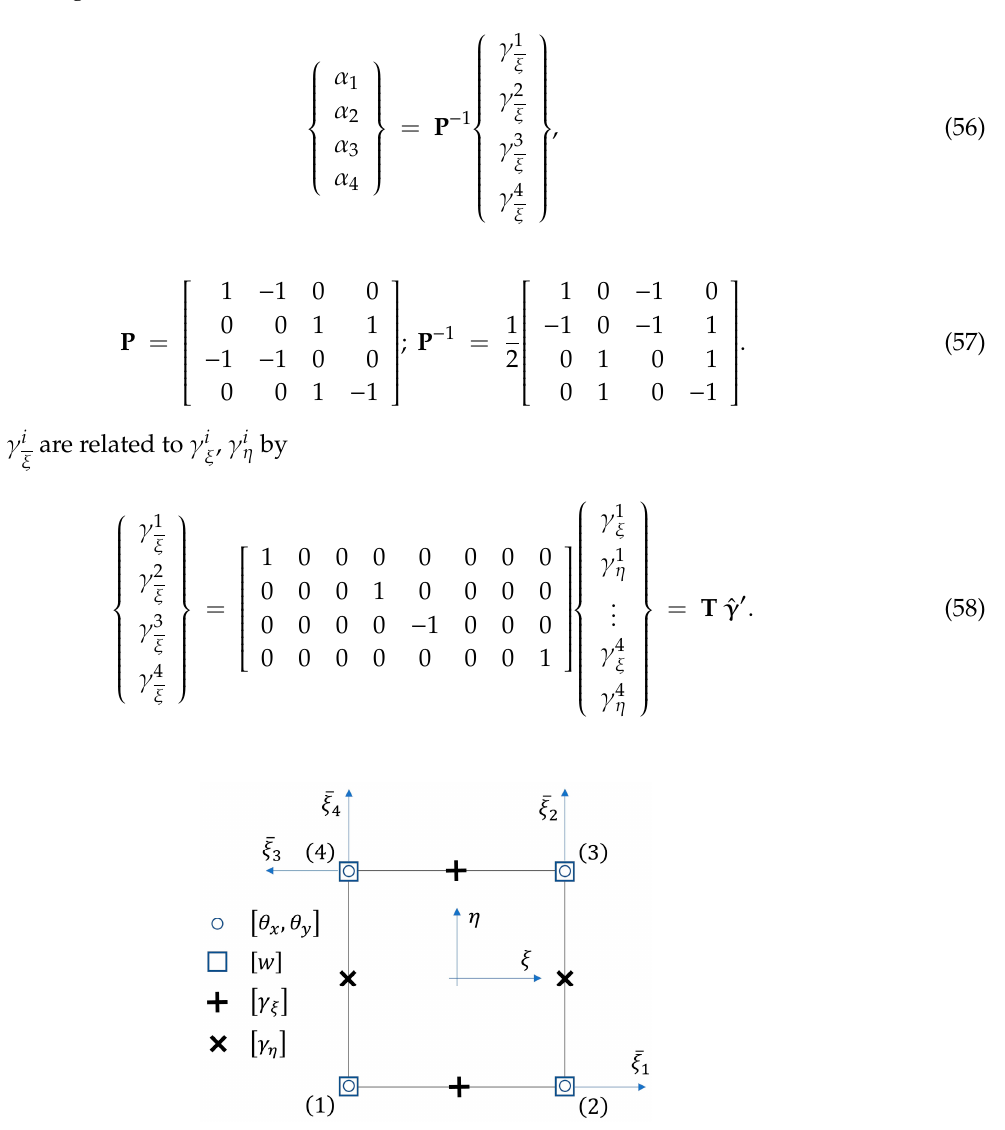
Figure 5. 4-noded quadrilateral, bilinear deflection and rotations Reissner–Mindlin plate element with the assumed linear transverse shear strain field.